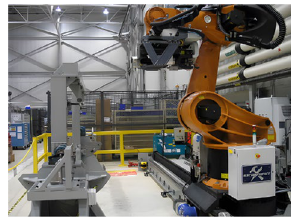
Figure 13 Mobile robot drilling system of EI